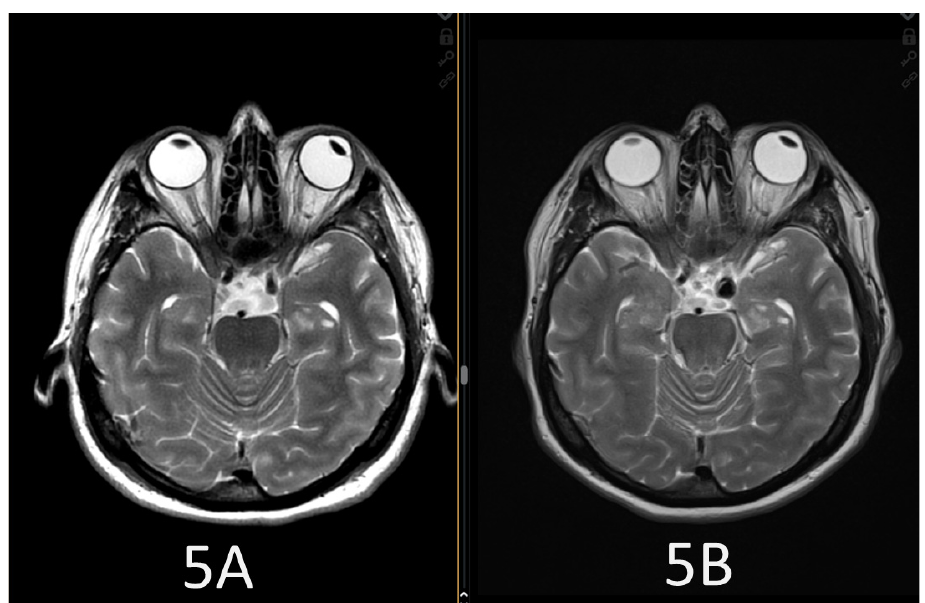
Fig. 5A,B. A Axial T2W MR image demonstrates normal calibre of the internal carotid artery in 3 months after surgery. B There is aneurysma at the same level on follow up MR after ischemic stroke in 7 months after